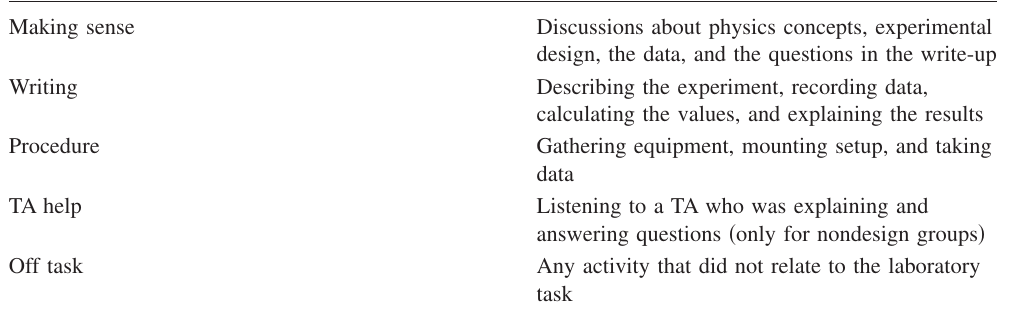
TABLE II. General codes.